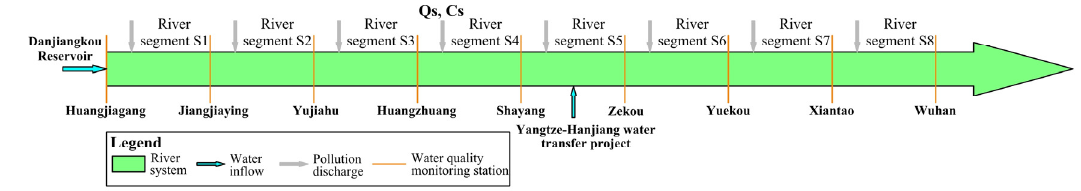
Figure 4. River segments in the main stream of the mid-lower reaches of the Hanjiang River.